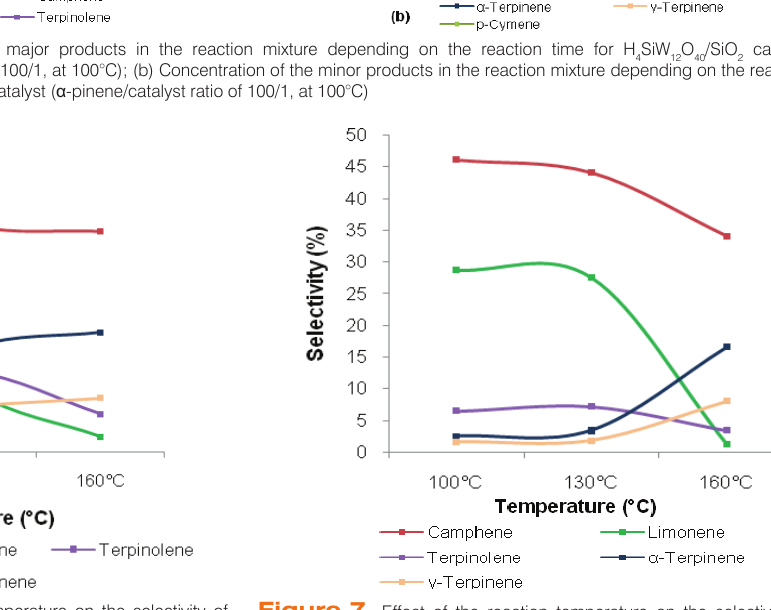
Figure 7. Effect of the reaction temperature on the selectivity of camphene, limonene and terpinolene ( α -pinene/catalyst: 100/1, H SiW O /TiO as a 4 12 40 2